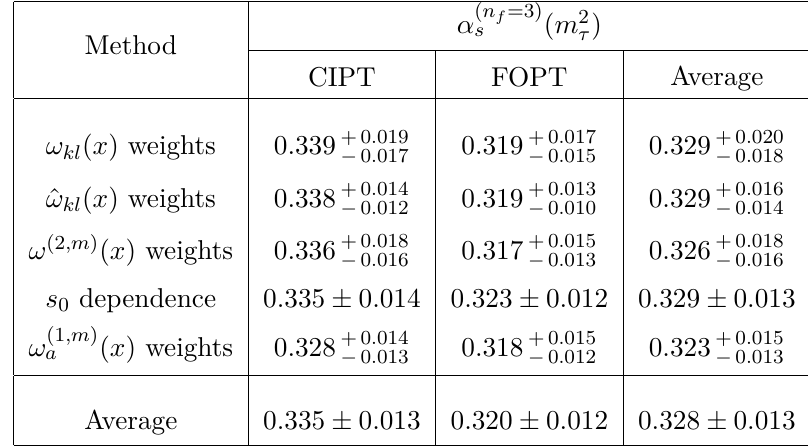
) from τ decay data, in the V + A channel τ